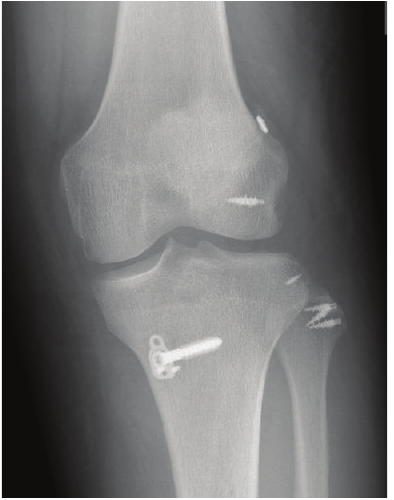
Figure 4: Anatomical single bundle anterior cruciate ligament reconstruction with the ipsilateral semitendinosus tendon was